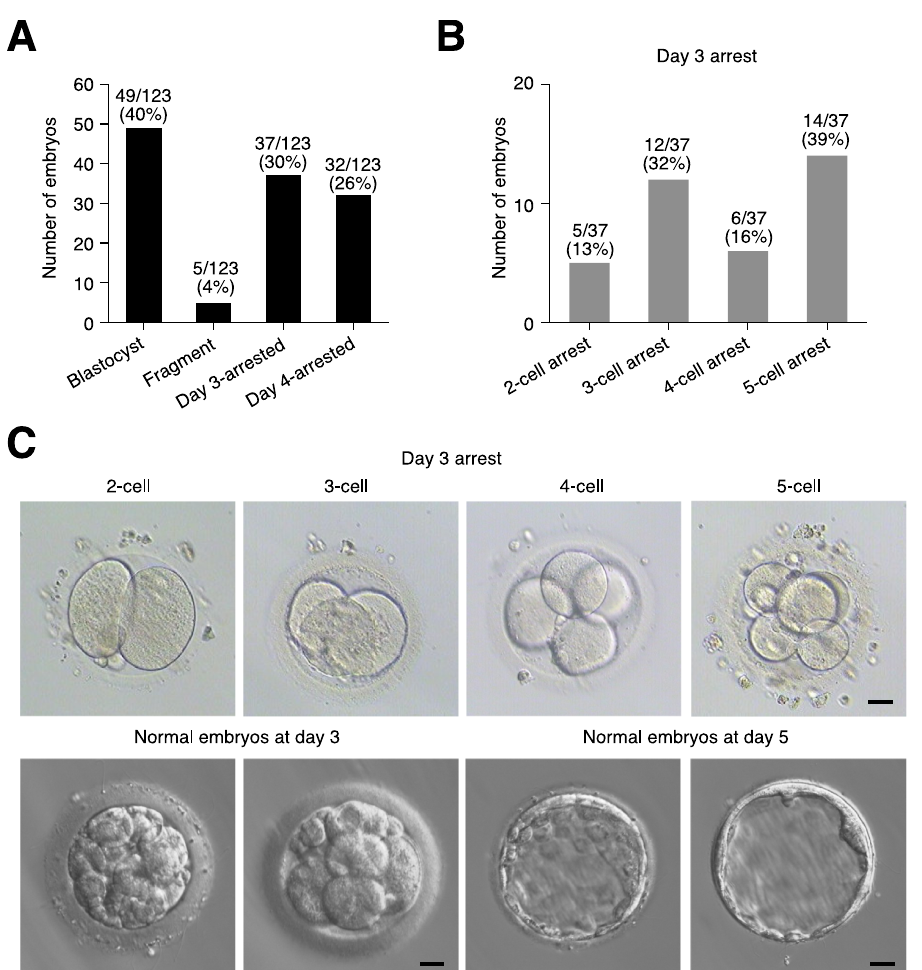
Fig 1. Human IVF embryos have poor in vitro developmental capability. AU : AbbreviationlisthavebeencompiledforthoseusedinFigs 1 (cid:0) 6 ; S 3 (cid:0) S 5 ; andS 7 (cid:0) S 10 : Pleaseverifythatallentriesarecorrect : ( A ) Typical outcomes for human IVF blastocyst development. Developmental results of 123 embryos were collected from 30 patients undergoing IVF. Underlying data can be found in S1 Data . ( B ) Number of blastomeres in the 37 embryos arrested on day 3 postfertilization. These embryos were defined as arrested and had normal morphology with distinct blastomeres, no unequal divisions, and no fragmentation. Underlying data can be found in S1 Data . ( C ) Bright-field images of uncompacted arrested human embryos between the 2-cell and 5-cell stages, and normal embryos at the same day of development. Scale bar = 20 μ m. IVF, in vitro